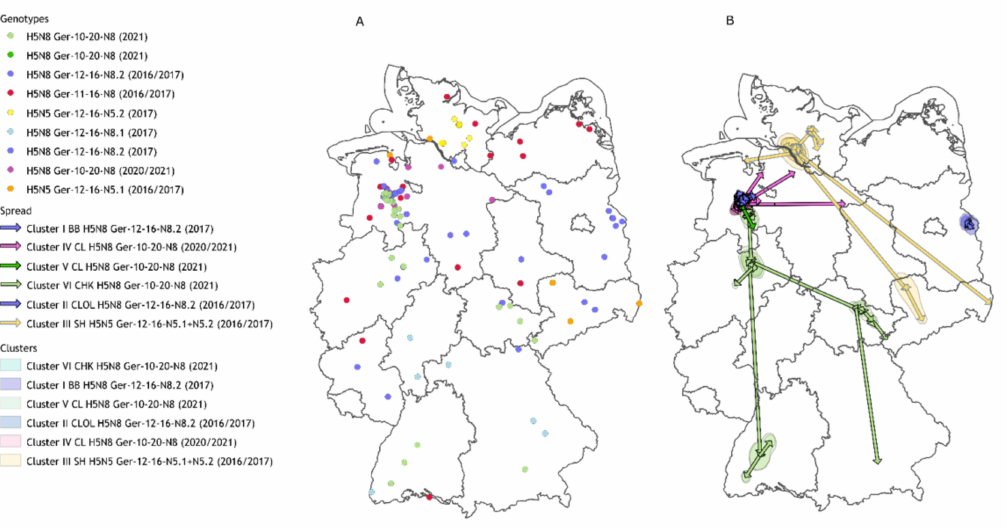
Figure 1. Geographic overview, genotype assignment, and connected clusters of HPAIV genomes from 2016/2017 and 2020/2021 in Germany. Panel ( A ): Sequenced outbreaks and cases with their assigned genotype (circles). Panel ( B ): Identified connected cluster areas (polygons) with their directed spread (arrows). BB—Brandenburg, CHK—Chicken, CL—Cloppenburg, OL—Oldenburg,